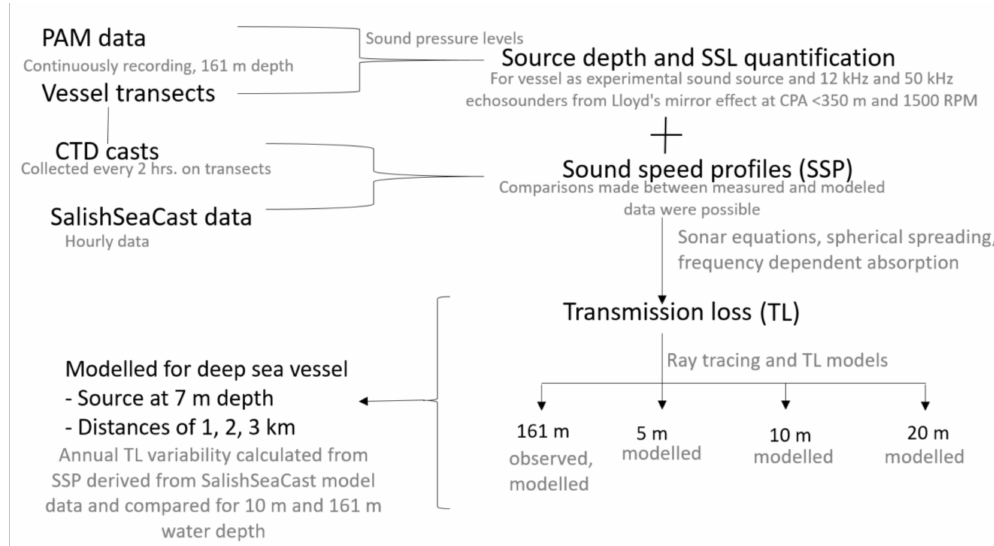
Figure 2. A flow diagram to demonstrate work plan and the integration of observed data and model